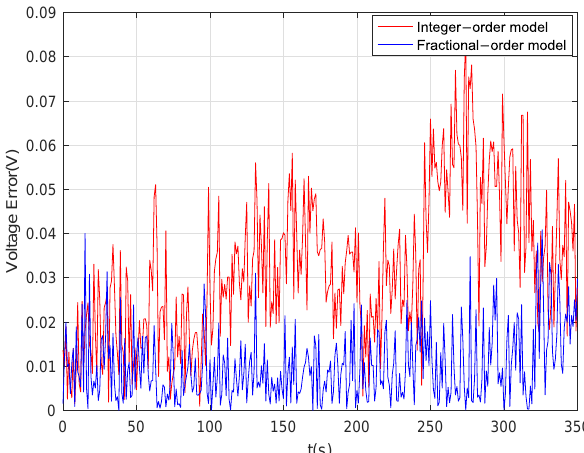
Figure 5. Output terminal voltage error